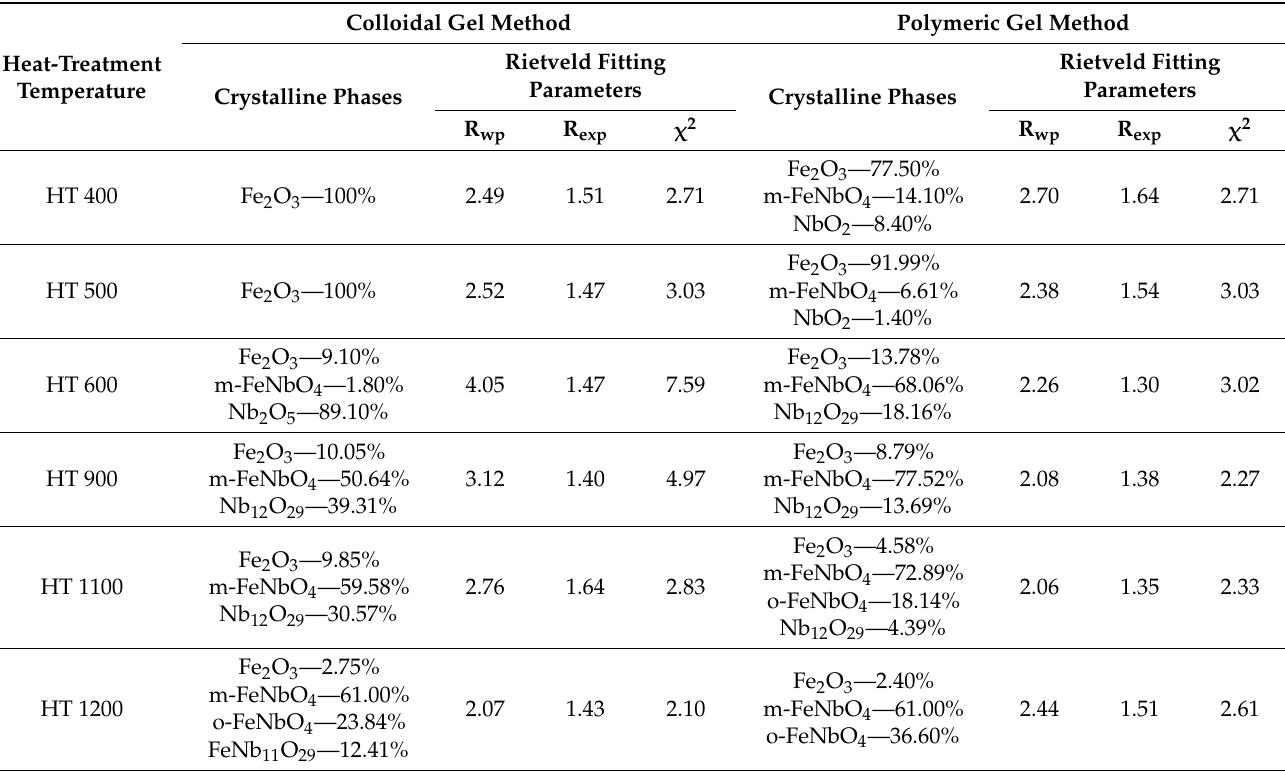
Table 1. Crystalline phases identification and percentages estimated via the Rietveld analysis for the prepared samples, along with the Rietveld fitting